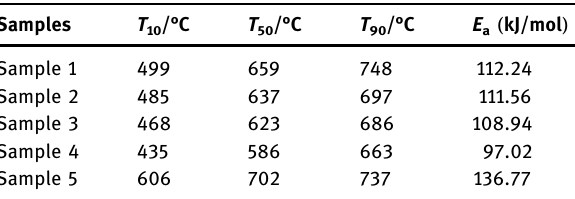
Table 4: Catalytic activities and E a of the catalysts for CH 4 combustion Samples